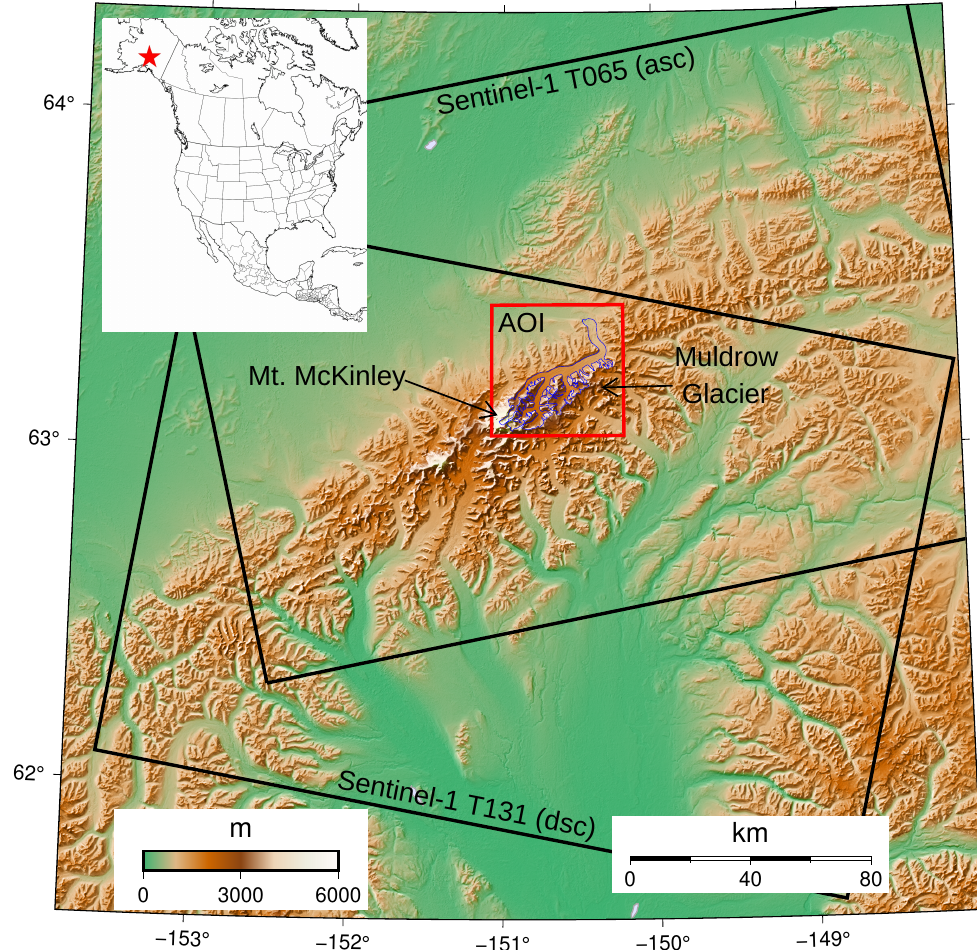
Figure 1. Study region is located in Denali National Park and Preserve of Interior Alaska. Footprints of Sentinel-1 ascending and descending swaths, used in this study, are outlined in black. Area of Interest (AOI) shows location of Muldrow Glacier, which is outlined in blue. Background is Advanced Spaceborne Thermal Emission and Reflection Radiometer (ASTER) digital elevation model (DEM) [15] with a spatial resolution of 30 m. Insert in top-left corner shows the location of the study region in North